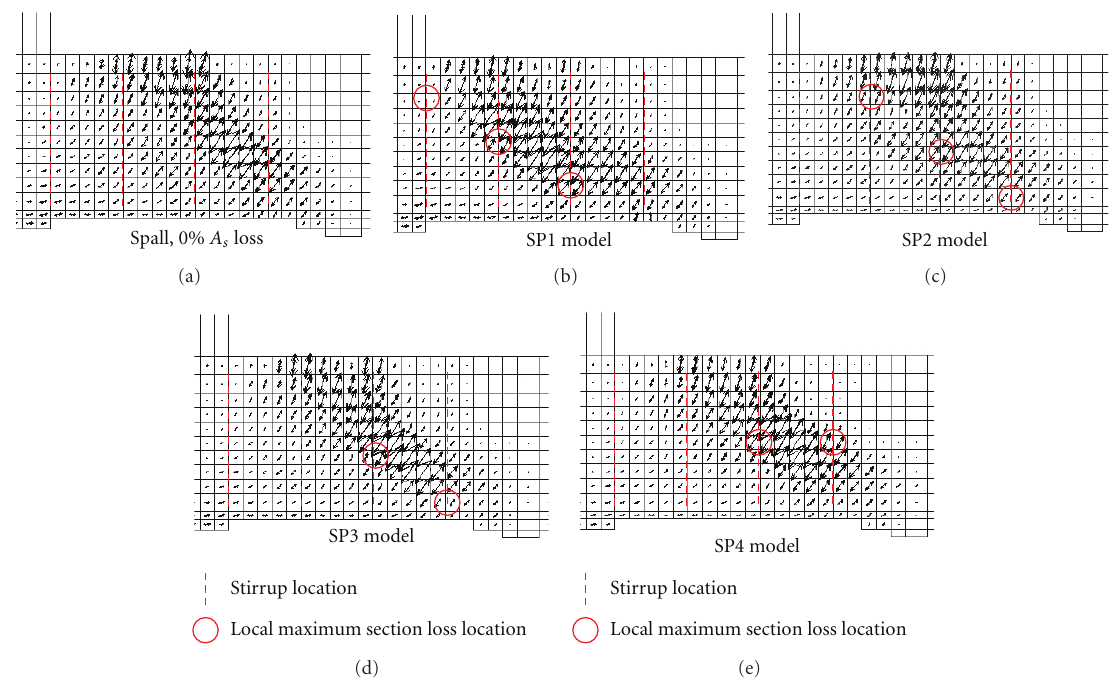
Figure 12: FE models with spatially distributed, local maximum section loss in stirrups.